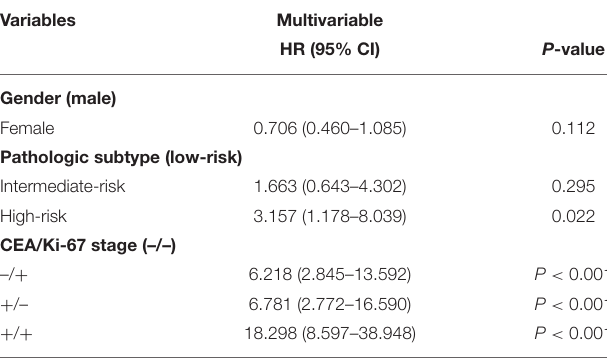
TABLE 3 | COX multivariable analysis of 5 y-DSS in 650 patients with stage I pulmonary adenocarcinoma. Variables Multivariable HR (95% CI) P -value